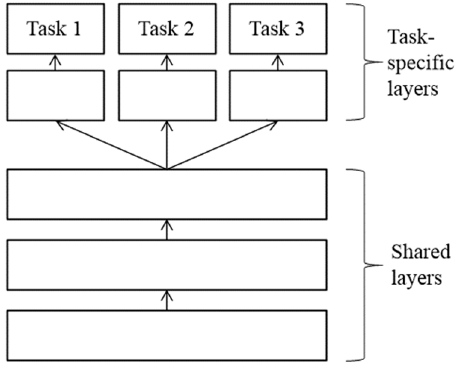
Figure 3. The structure of multi-task learning model using hard-parameter sharing